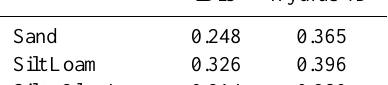
Fig. 6. Same as in Fig. 4, except for daily Hydrus-1D (black) and G-E-bucket model (1-blue, 2-yellow) 10-year simulations (see Table 3). The node spacing in the Hydrus-1D simulation is 1.5cm, and ET p is calculated from the Priestley-Taylor relationship. Table 4. Long-term mean annual ET a /ET p , as simulated by IBIS and Hydrus-1D in the 10-year model sensitivity experiments (Ta- ble 3) using free-drainage lower boundary conditions. Soil hy- draulic parameters from Rawls et al. (1982) are used in the simu- lations.